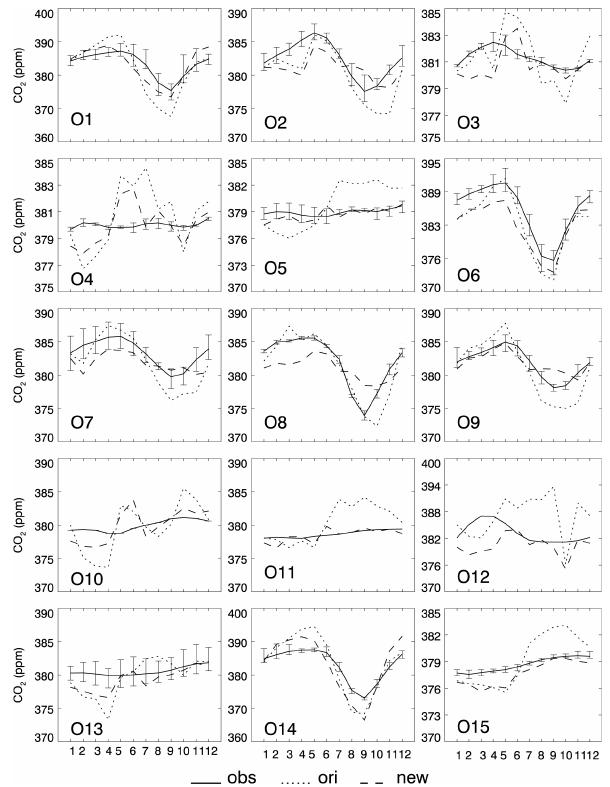
Fig. 9. Comparisons of regionally averaged values of CO 2 between model results from GEOS-Chem with the original emission inven- tory (dotted line) and the new emission inventory (dashed line) and GLOBALVIEW-CO 2 (solid line) for 15 ocean regions in 2006 (15 ocean regions are shown in Fig. 4). The error bar represents the spread of the observations.